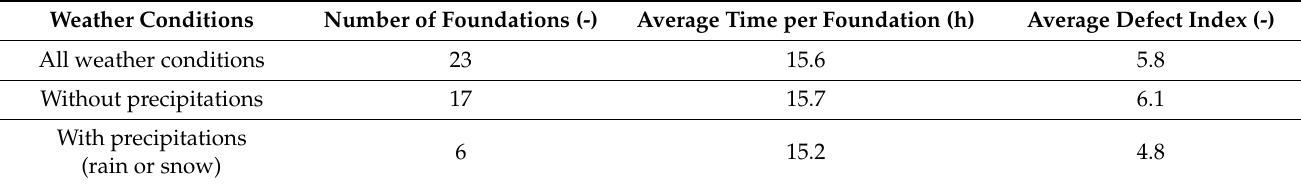
Table 4. Production time per foundation and defect index for different weather conditions.